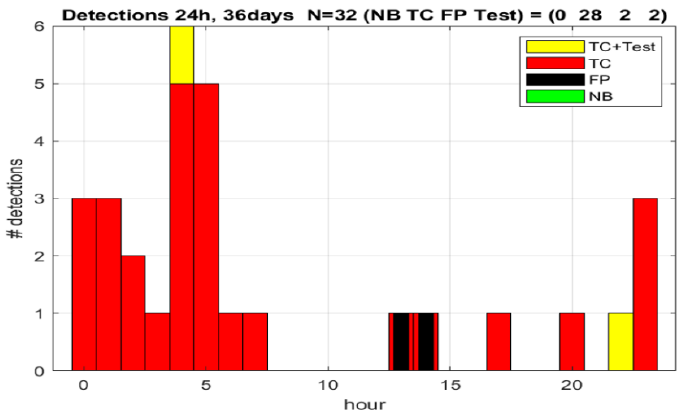
Figure 5. Detection statistics from optimized personal parameters (the same notations as on Figure